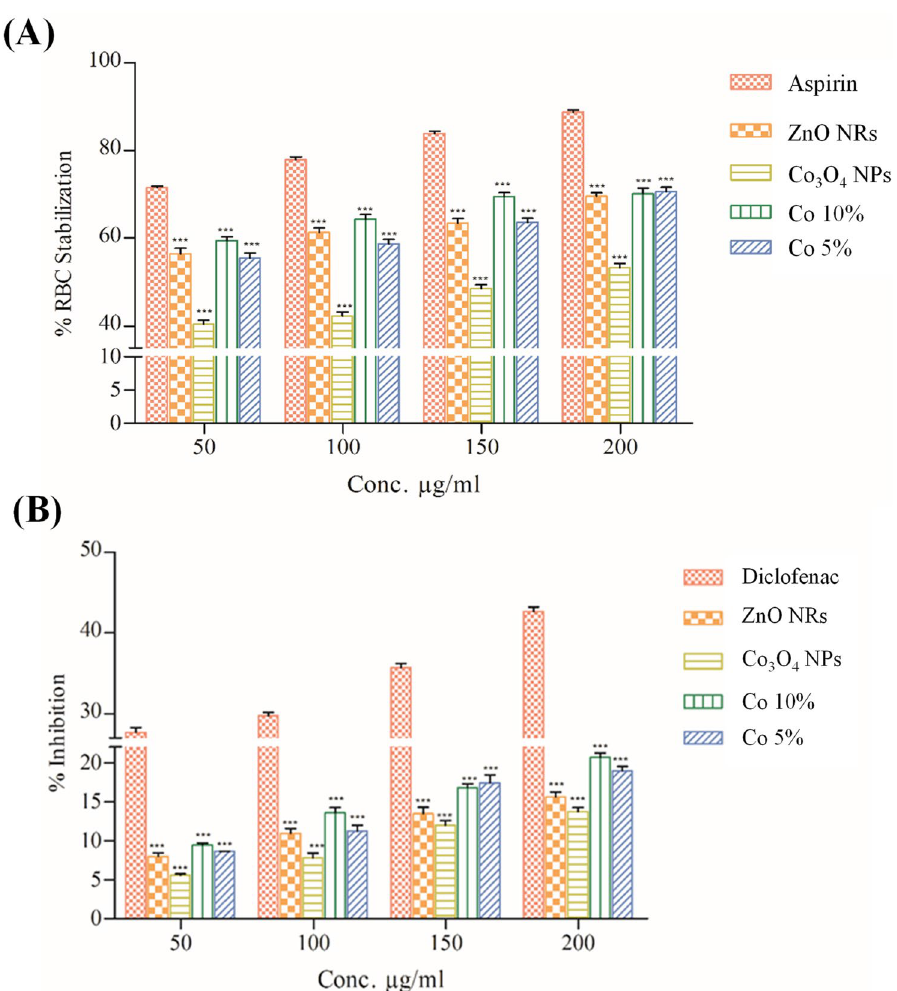
Figure 14. Anti-inflammatory effects of ZnO NRs, Co 3 O 4 NPs, Co 10%, and Co 5% nanocomposite assessed against ( A ) Heat-induced egg albumin denaturation and (B ) RBC Stabilization of Leukocyte (%). Data represent the mean ± SD; N = 3. * P < 0.01, ** P < 0.001, *** P < 0.0001 compared with